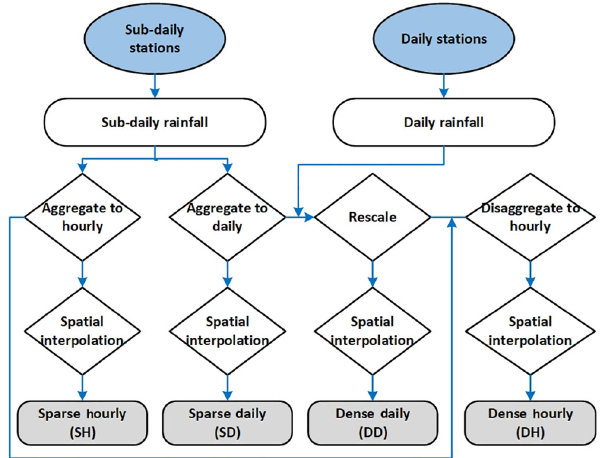
Figure 3. Schematic representation of four different rainfall